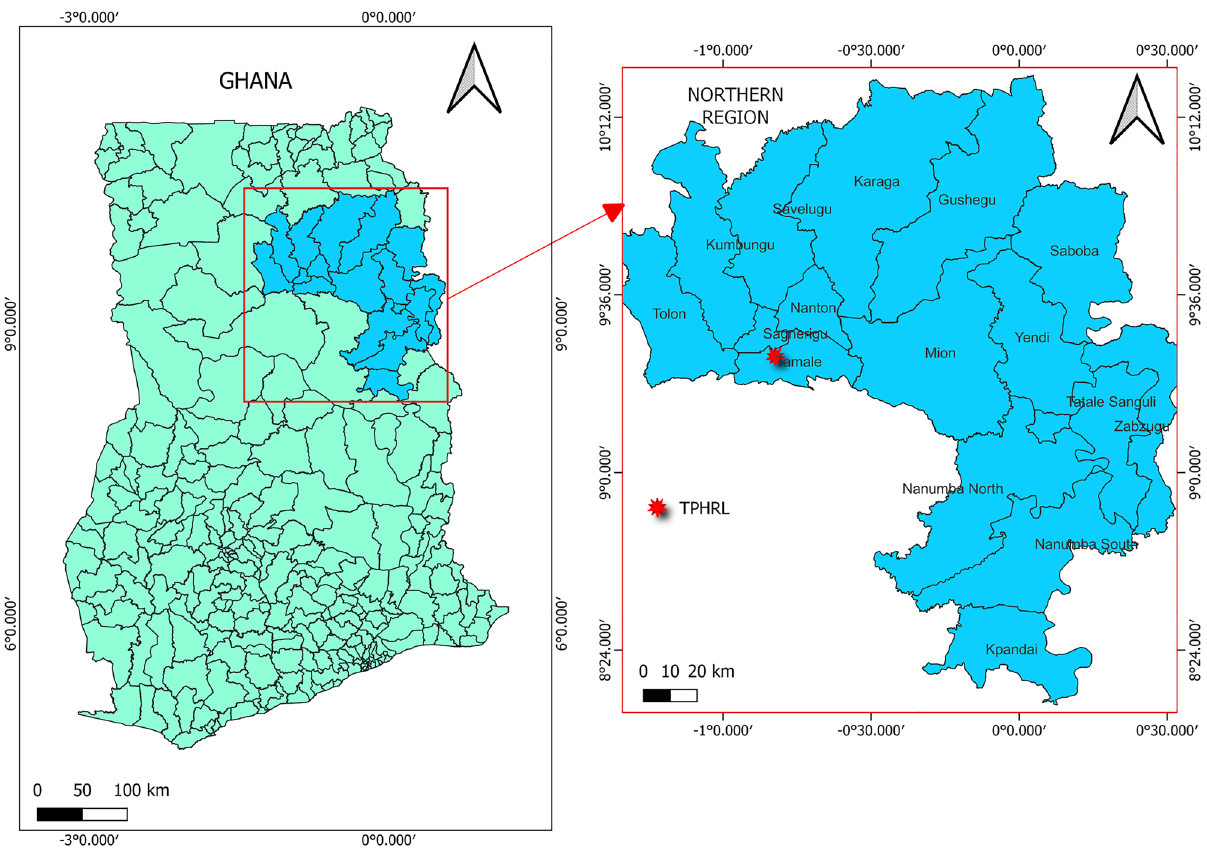
Figure 1. Geographical map of the study